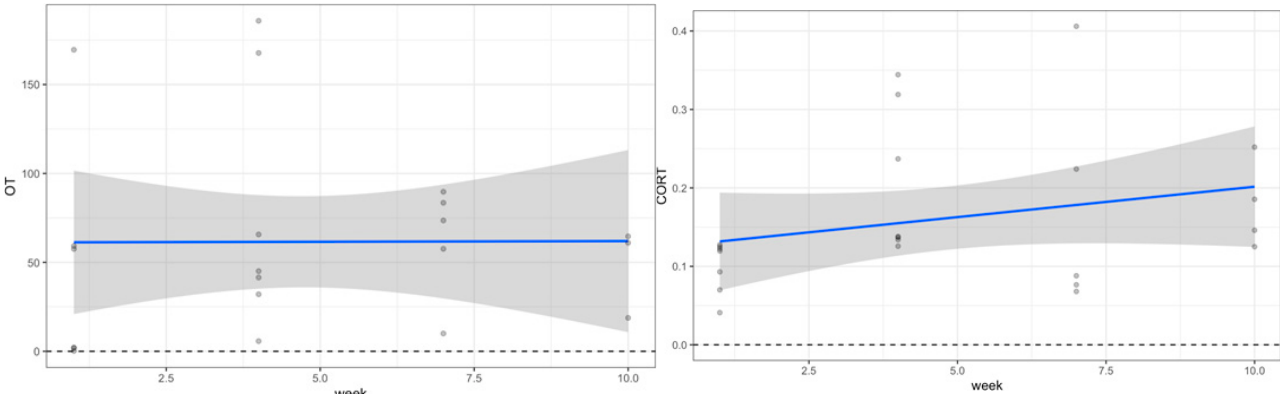
Figure 1. Oxytocin and cortisol change from week 1 to 10 with trend line. Table 1. Pre/post changes for oxytocin (OT) and cortisol (CORT) of youth and horses.